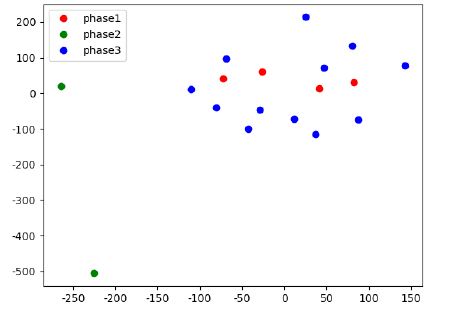
Figure 7. The ISCXIDS 2012 partial alert